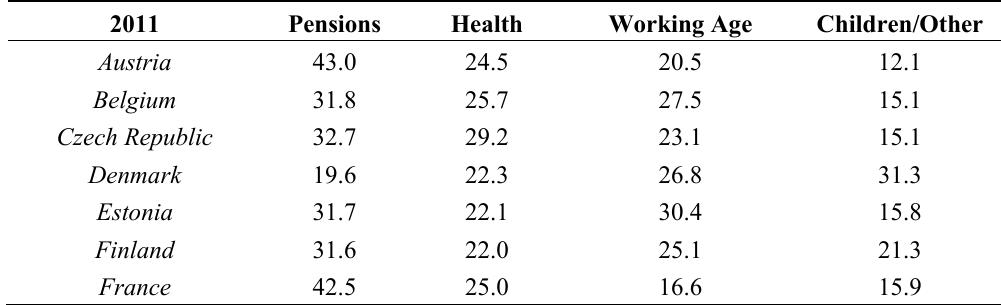
Table 2. Structure of entitlement programs, 2011. Percentage of total entitlement programs in